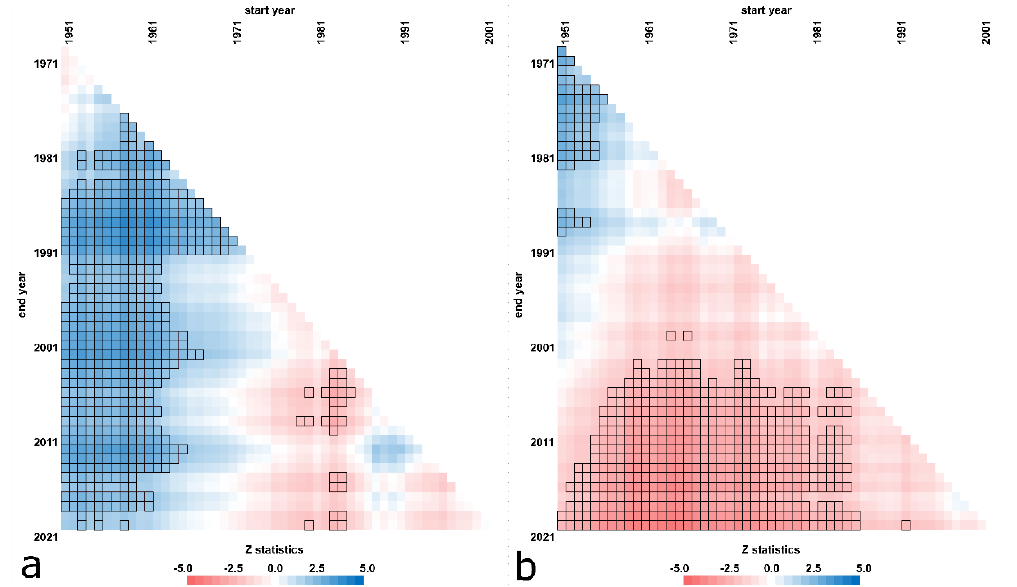
Figure 8. Multitemporal trend analysis of 7 day minimum flows (DL7) for the Gwda ( a ) and Flinta ( b ) rivers (marked fields indicate statistically significant changes at the level 0.05).